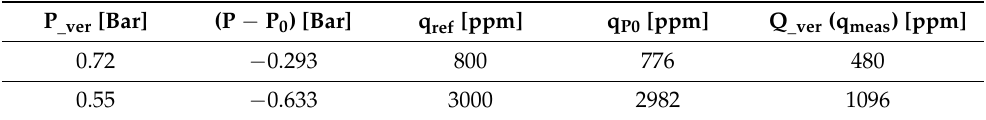
Table 2. Verification parameters.